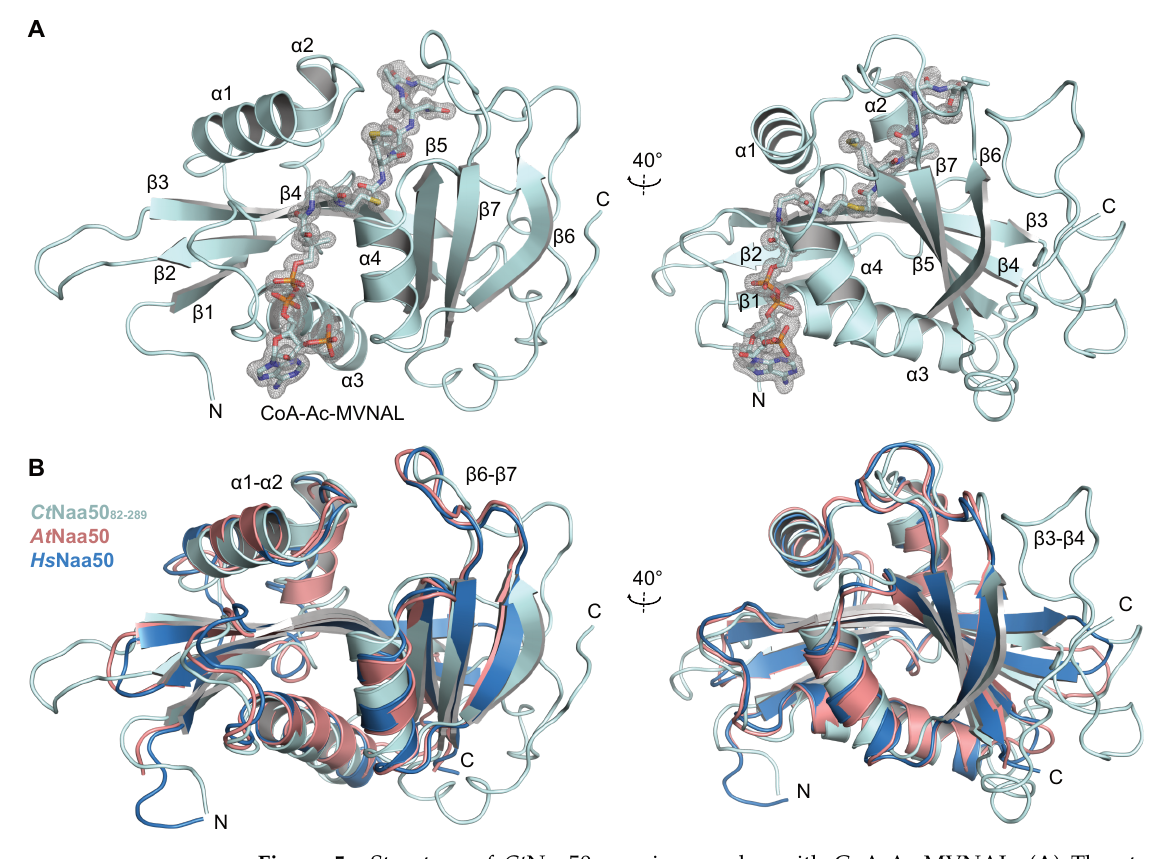
Figure 5. Structure of Ct Naa50 82-289 in complex with CoA-Ac-MVNAL. ( A ) The structure of Ct Naa50 82-289 (teal) in ribbon representation is shown in complex with CoA-Ac-MVNAL in sticks. The protein adopts a GNAT fold. The 2m F obs -DF calc maps are at a contour level of 1 σ . ( B ) Ct Naa50 82-289 superimposes well with At Naa50/CoA-Ac-MVNAL (salmon) [39] and Hs Naa50/CoA/MLGPE (blue) [51]. Some loops are longer in Ct Naa50, especially loop β 3– β 4.